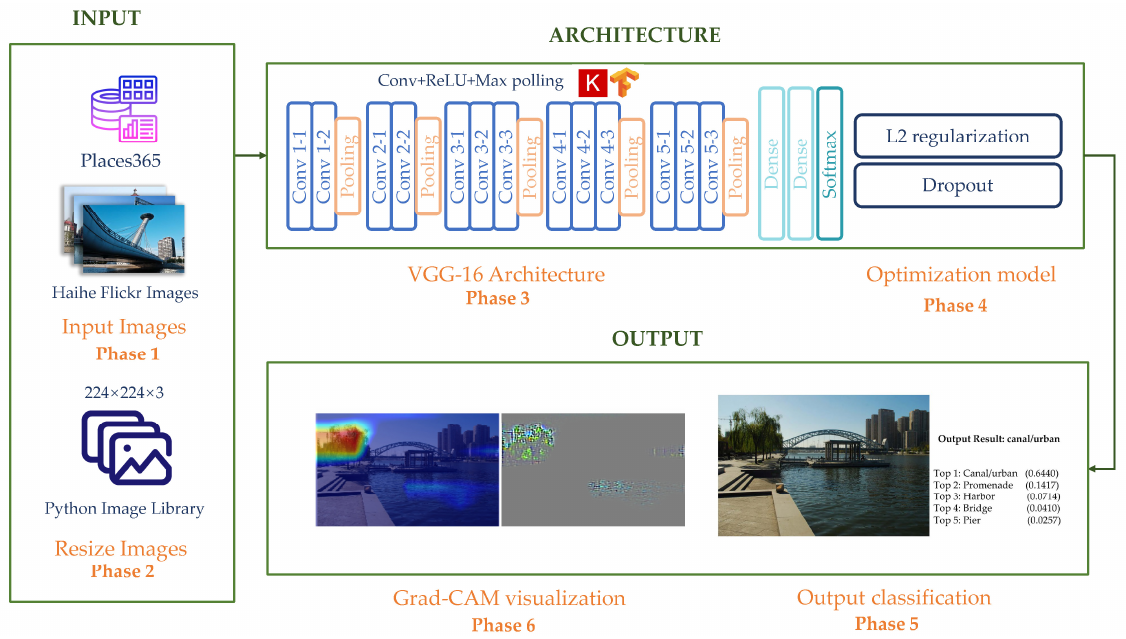
Figure 3. VGG-16 architecture for Image classification framework.